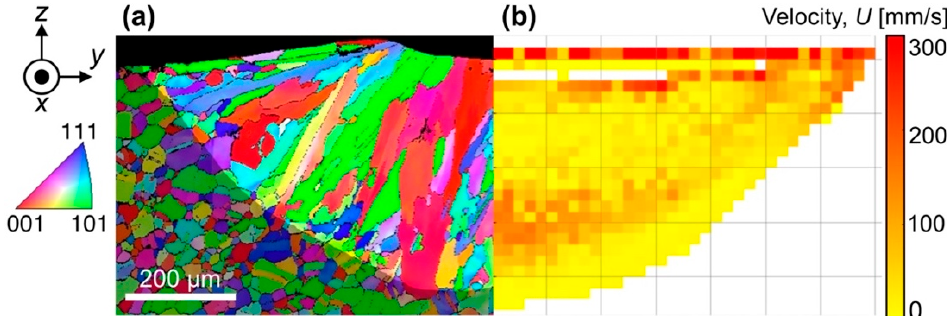
Figure 13. Comparison of ( a ) solidification microstructure (EBSD IPF map) of melt region in 316L SS formed by scanning electron beam and ( b ) a corresponding snapshot of CtFD simulation colored by fluid velocity. Table 3. Liquidus and solidus temperatures of 316L SS and 304